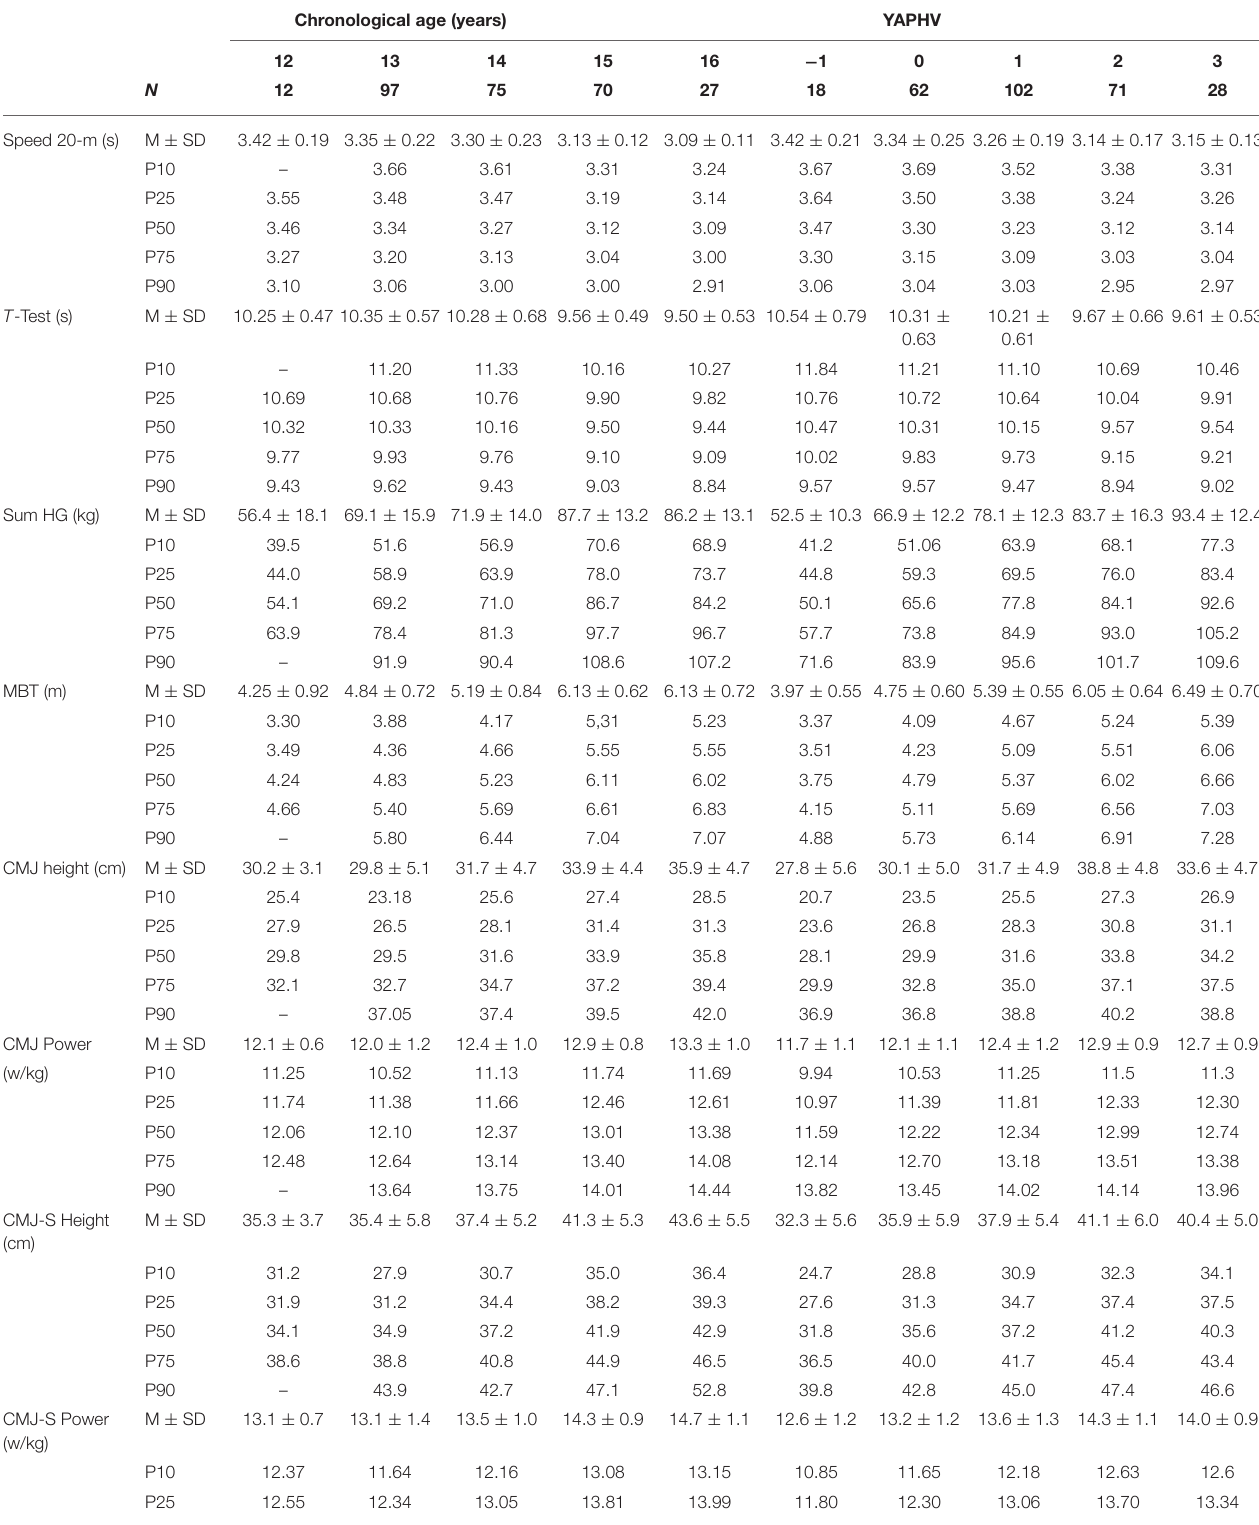
TABLE 4 | Descriptive statistics (mean ± SD) and reference values (10th, 25th, 50th, 75th, and 90th percentiles) for fitness of young Portuguese male basketball players, according to their age and maturity